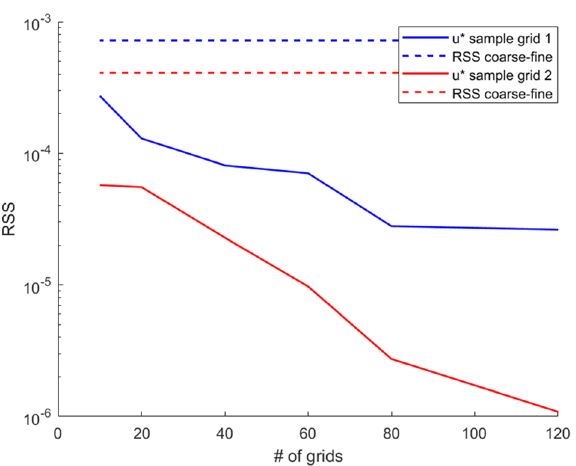
Figure 6. Plot of the performance of the KBaNNs as a function of the scarcity of the training data. Note that in all cases the RSS error of the KBaNNs was less than that of the coarse mesh.